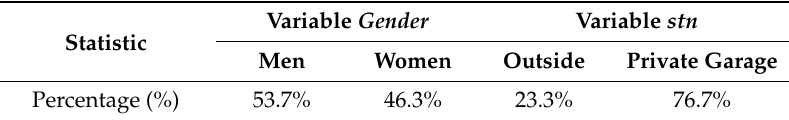
Table 2. Relative frequency of policies by gender and type of parking.